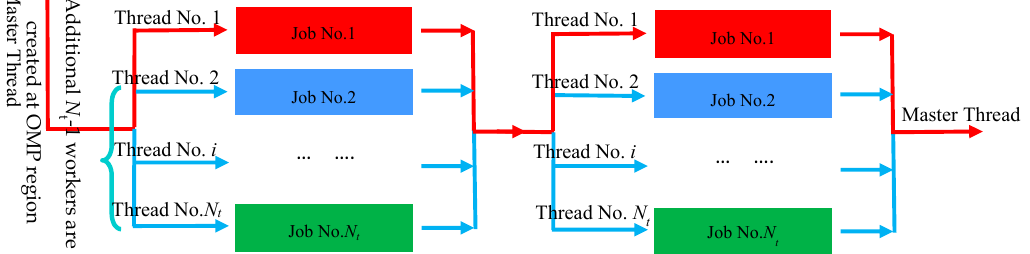
Figure 5. Schematic of the two main OpenMP parallel processes in the HAMS (Hydrodynamic Analysis of Marine Structures) program.